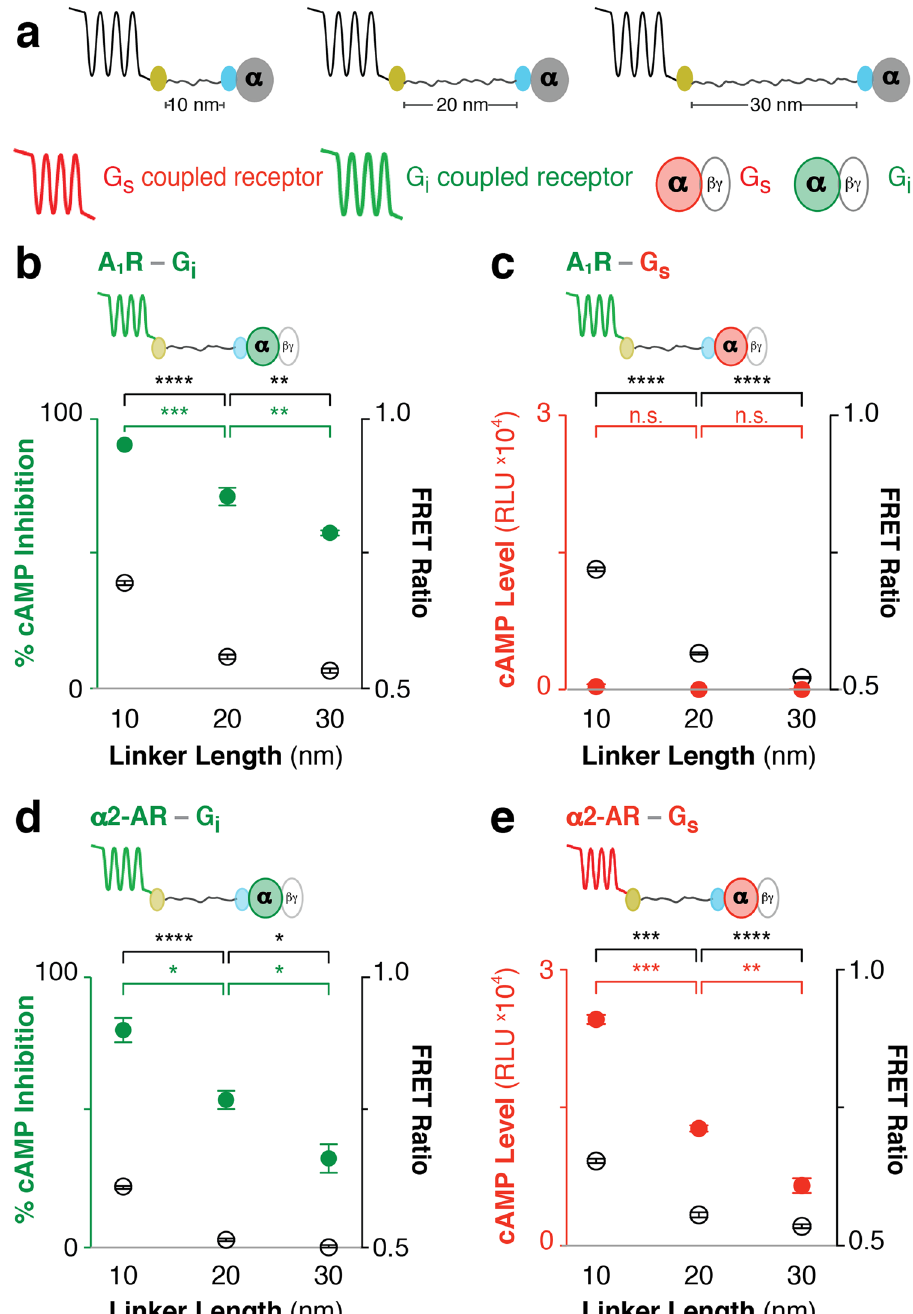
Figure 6. ER/K linker length tunes basal GPCR-Gi protein downstream response in live cells. ( a ) Schematic of the GPCR-G protein fusions. Color represents cognate GPCR-G protein pair and corresponding downstream response (red: α 2-AR, Gs, and cAMP levels; green: A 1 R, α 2-AR, Gi, and cAMP inhibition). (b – e ) Fusion type is indicated on the top left. FRET Ratios (525 nm/475 nm; open black circles, right y-axis) and basal (ligand-free) downstream response (filled colored circles, left y-axis) are compared to ER/K linker length (nm). ( b ) Percent inhibition of 1 μ M forskolin induced cAMP production for canonical Gi coupled adenosine type 1 receptor (A 1 R). ( c ) Basal cAMP levels for A 1 R-Gs fusions. ( d ) % cAMP inhibition for Gi fusions and ( e ) cAMP levels for Gs fusions to α 2-AR, a promiscuous Gs/Gi coupled receptor 28 . ( b , d ) Representative experiment with at least three replicates per condition. ( c , e ) Data are derived from at least three independent experiments, with at least three replicates per condition. ( b – e ) One-way ANOVA with a Tukey’s post-test was performed for FRET measurements (black) and downstream response (colored). Data are represented as mean ± S.E.M. * p ≤ 0 . 05 ; ** p ≤ 0 . 01 ; *** p ≤ 0 . 001 ; **** p ≤ 0.0001 ). For additional statistical analysis see Supplementary Table